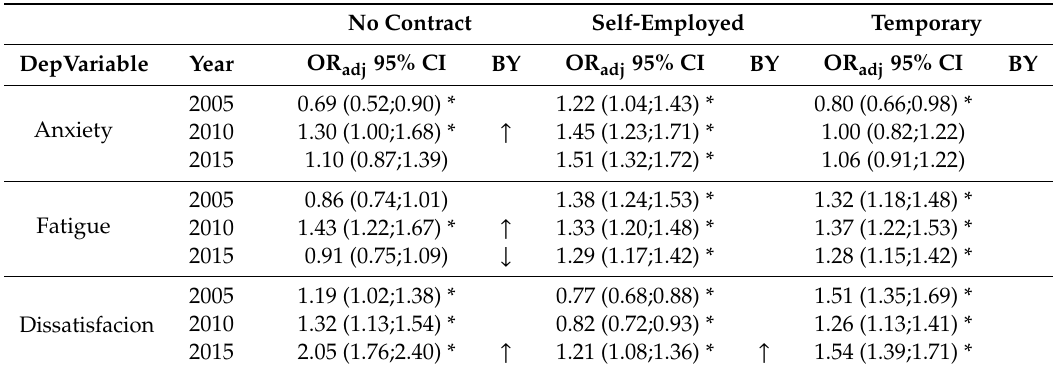
Table 1. Relationship between well-being and employment contract in 2005–2015 (reference: indefinite